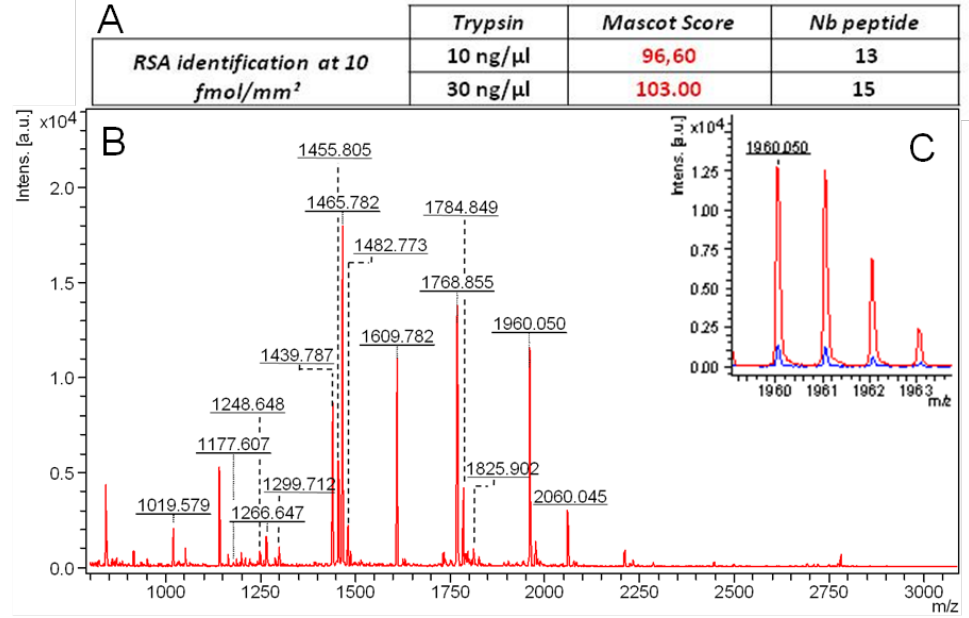
Figure 4. Mascot Identification score obtained and the number of peptides detected after reduction and digestion of the deposited RSA at 10 fmol/mm² using 10 or 30 ng/µL of trypsin ( A ). MS spectrum of RSA after digestion by the solution containing 30 ng/µL of trypsin ( B ) Difference in intensity of a specific RSA peak (1,960.05 m/z ) between 10 ng/µL (blue spectrum) and 30 ng/µL (red spectrum) conditions ( C